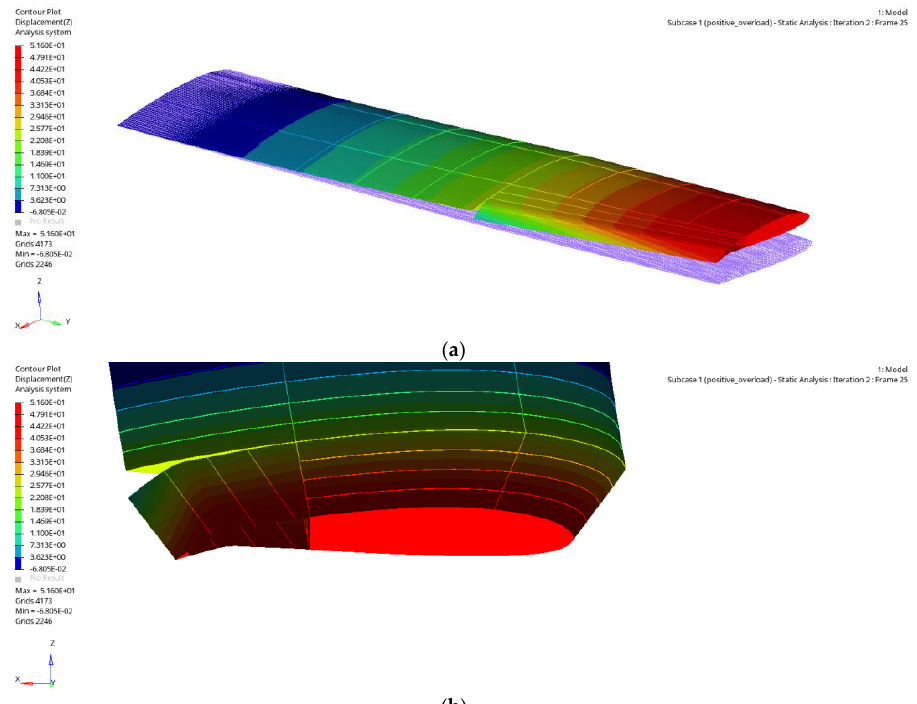
Figure 20. Z-direction displacement (condition D): ( a ) global deformation; ( b ) deformation of flexible skin.